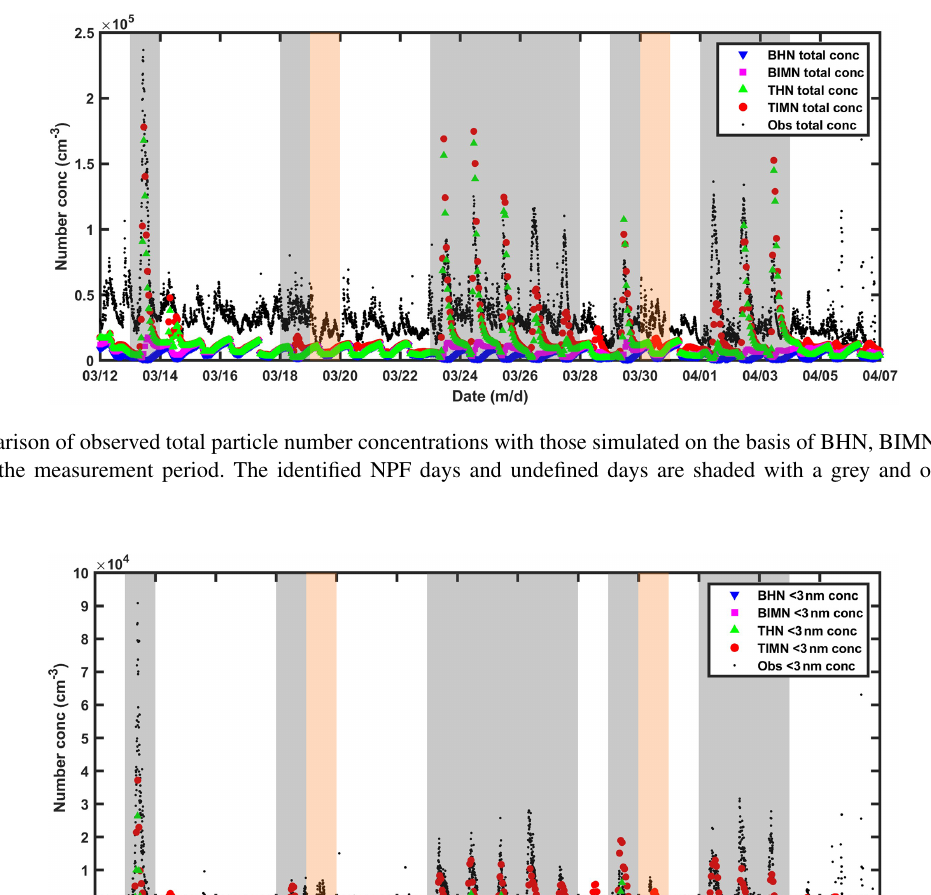
Figure 4. Time series of temperature (at 10m above the displacement height) and RH (at the first layer, about 70m above the surface) input to the model and time series of measurements at a height of about 10m during the 26d campaign.